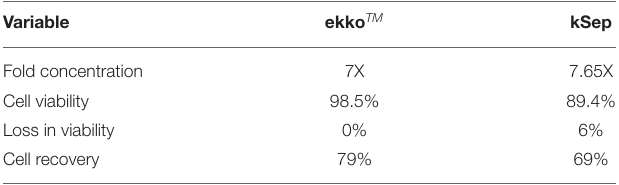
TABLE 4 | Concentration of cells using closed